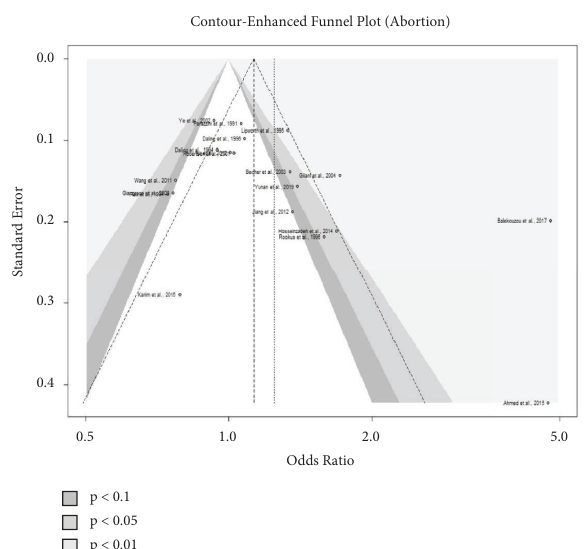
Figure 7: Contour-enhanced funnel plot of all studies of